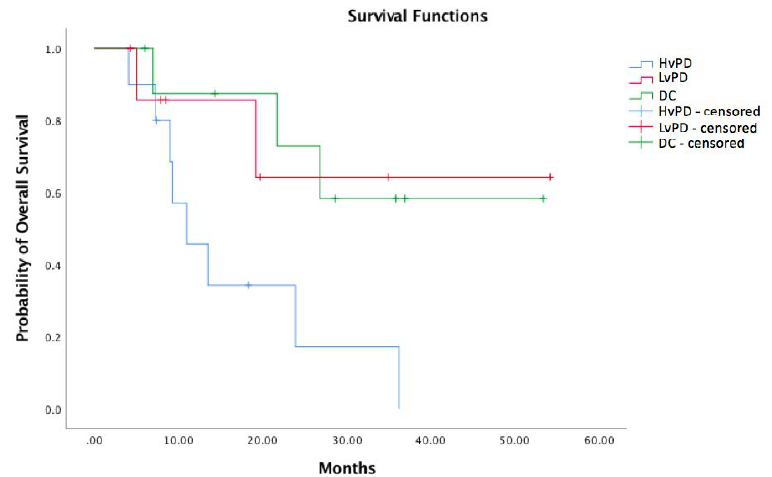
Figure 1. Overall survival according to the tumor growth rate. HvPD: Higher velocity PD (blue); LvPD: Lower velocity PD (red); DC: Disease control (green).